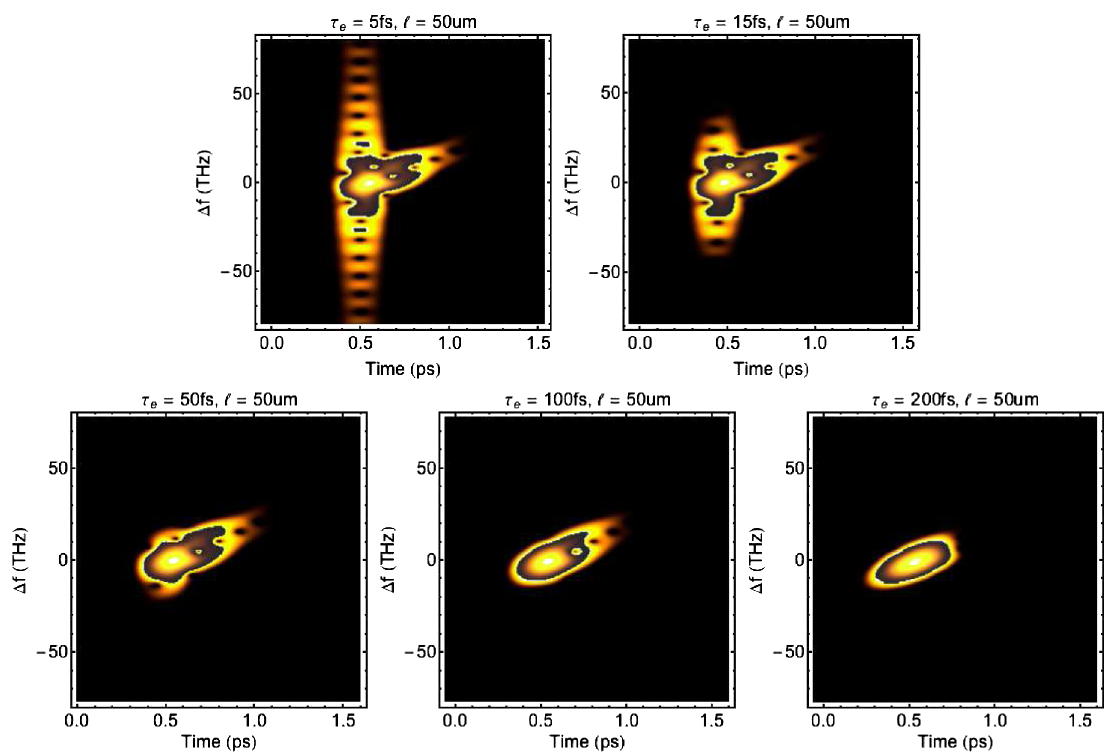
FIG. 5. Simulation results for various bunch lengths measured using a 50 (cid:10) m crystal with a chirped probe. Each image is plotted using its own normalized false color scale.